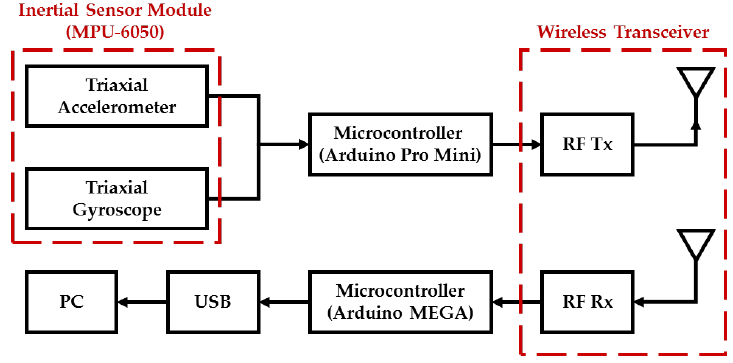
Figure 2. Wearable motion sensing device.